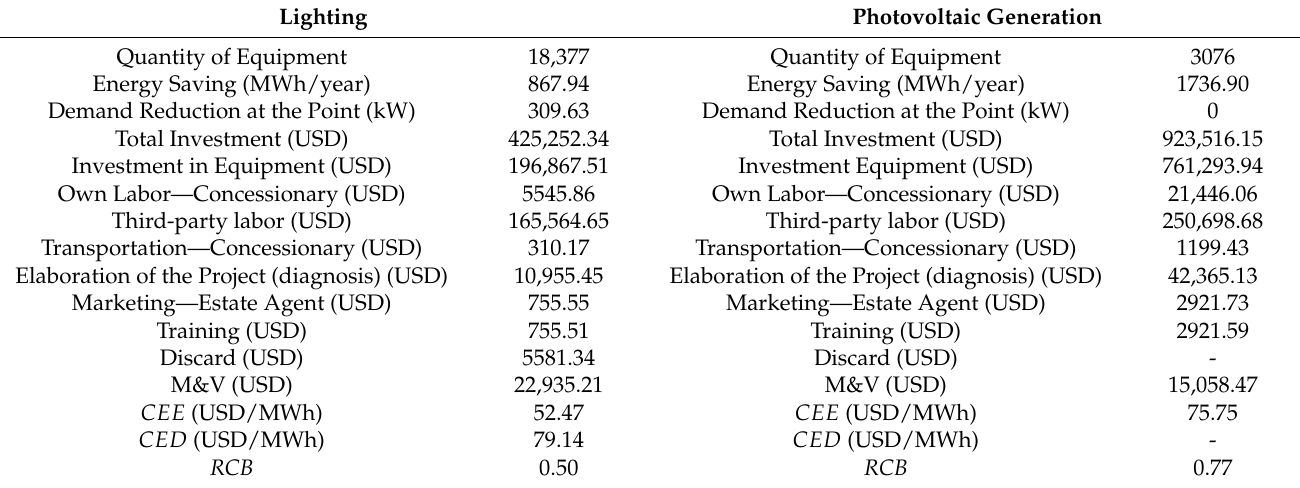
Table 12. Summary of the Key Project